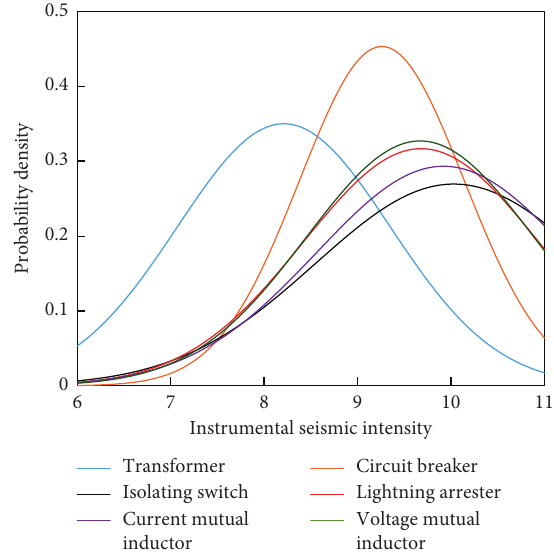
Figure 3: Damage probability curves for all kinds of high-voltage electrical equipment.